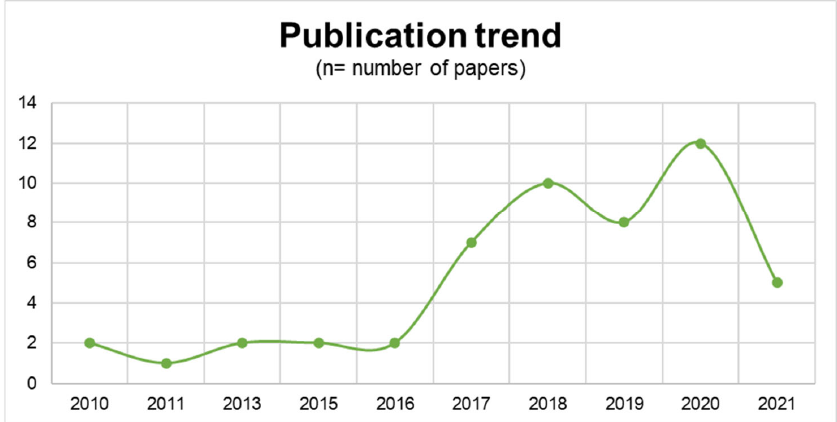
Figure 3. Number of included studies by year. Data from 2021 do not include the full year as the search was performed in August 2021. search was performed in August